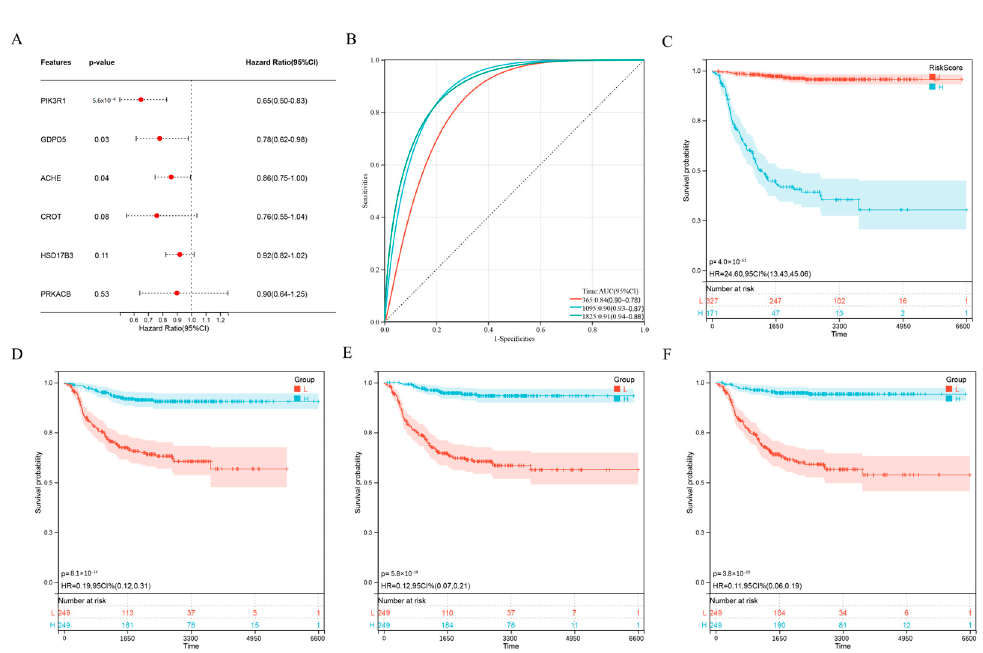
Figure 3. Further optimization of wind direction score. ( A ) Multivariate Cox regression analysis of 6 genes. ( B ) Kaplan–Meier analysis of novel 3-gene prognostic risk scores. ( C ) ROC curve analysis of novel 3-gene prognostic risk scores. ( D – F ) Kaplan–Meier analysis of ACHE ( D ), GDPD5 ( E ) and PIK3R1 ( F ).